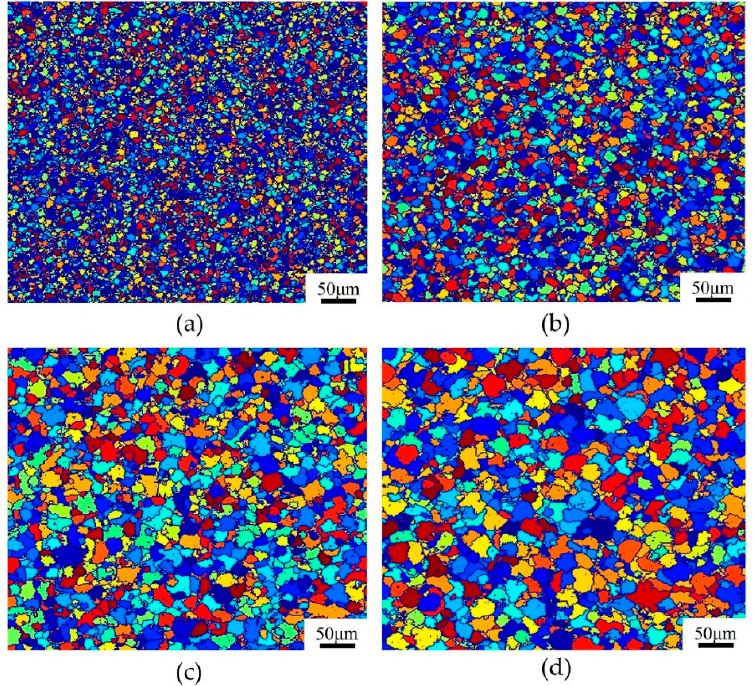
Figure 11. Simulated microstructural evolution of T15MN HSS with the strain of 0.9 at a strain rate of 0.1 s − 1 and deformation temperatures of ( a ) 1273 K; ( b ) 1323 K; ( c ) 1373 K; ( d ) 1423 K.